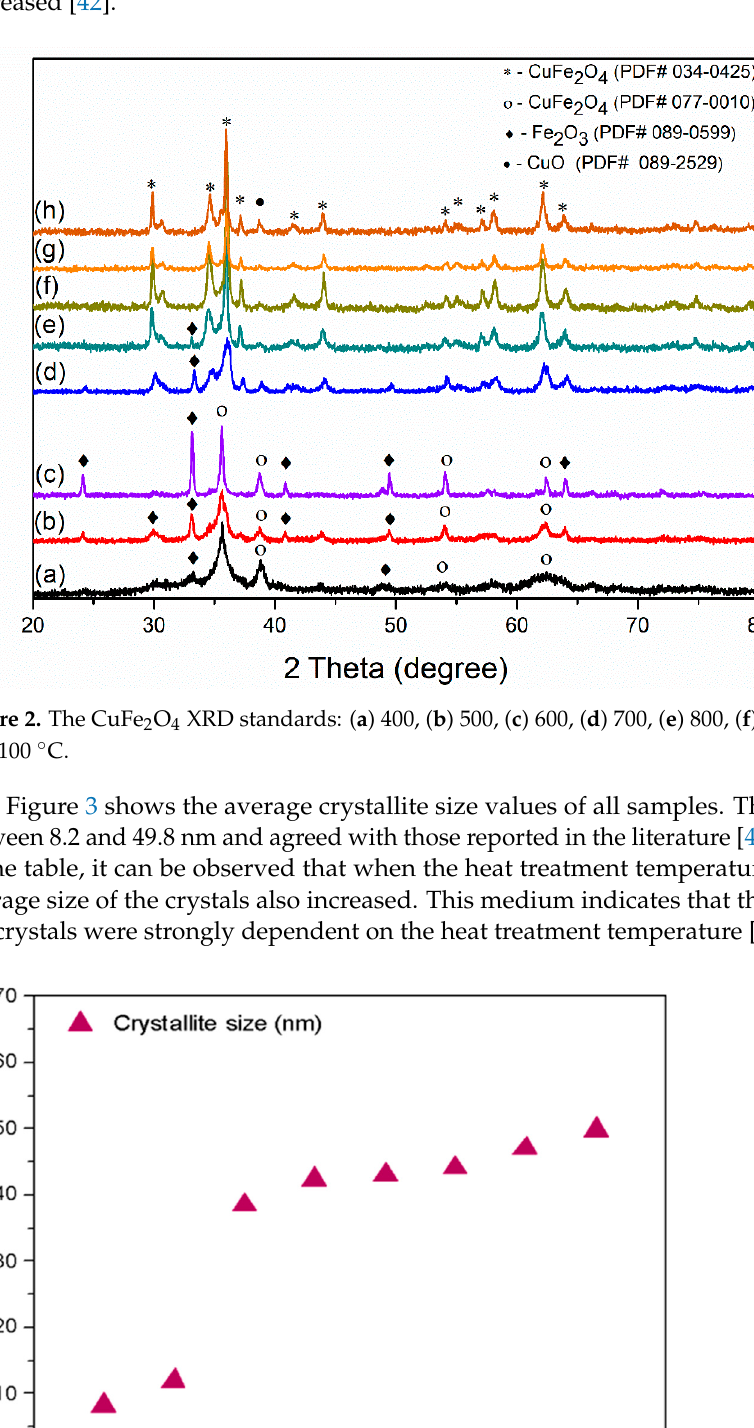
Figure 3. The crystallite size of CuFe 2 O 4 heat-treated at different temperatures.